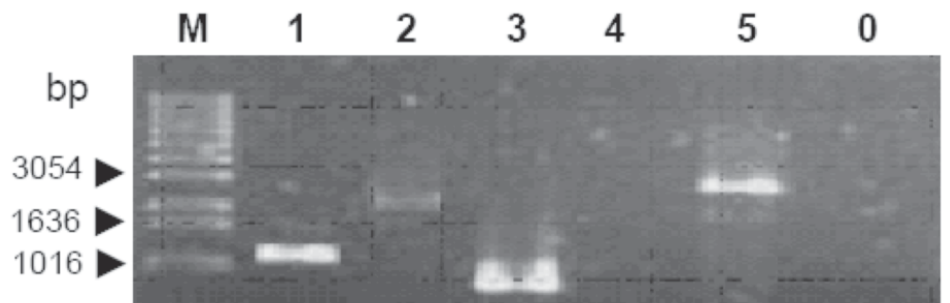
Fig. 1. PCR amplification of TYLCSV DNA fragments from infected tomato plants, using several primer pairs. Lane 1, MA14/PTYc1023; lane 2, PTYv369/MA15; lane 3, TYS- Sac v/TYS- Sph c; lane 4, TYS- Sph v/TYS- Sph c; lane 5, TYS- Nco v/TYS- Nco c. Lane 0, no DNA template. M, molecular marker, 1 Kbp ladder (Invitrogen). Note that the full- length genome of TYLCSV from Morocco was amplified in the sample in lane